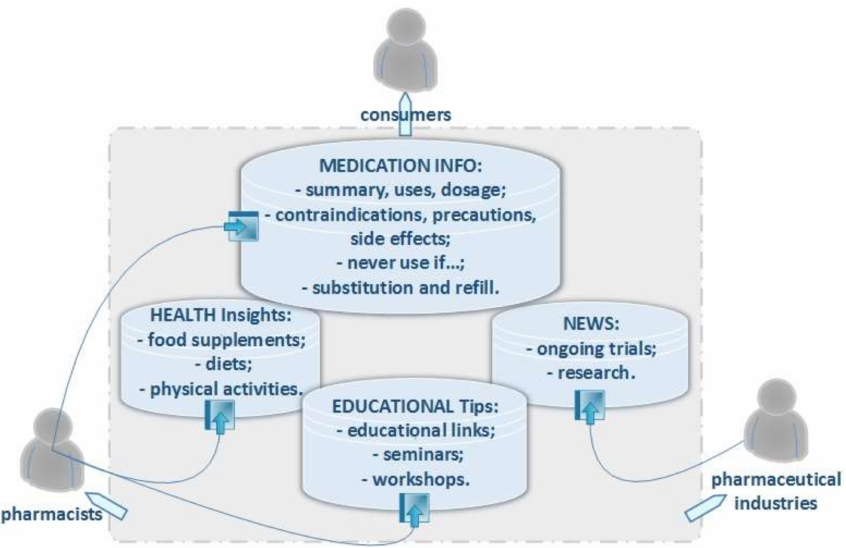
Figure 1. Stakeholders and Information categories in